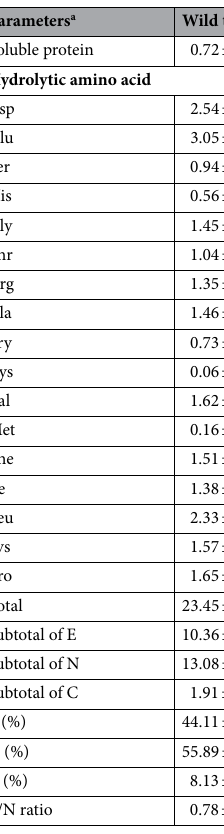
Table 2. Soluble protein and amino acids in sesame leaves (mg/g). a Asp aspartic acid, Glu glutamine, Ser serine, His histidine, Gly glycine, Thr threonine, Arg arginine, Ala alanine, Try tyrosine, Cys cysteine, Val valine, Met methionine, Phe phenylalanine, Ile isoleucine, Leu leucine, Lys lysine, Pro proline, E essential amino acids, N non-essential amino acids, C essential amino acids only for children. b Values are means ± standard deviation ( n = 3). Data in the same row followed by * and ** are significantly ( P < 0.05) and very significant ( P < 0.01) different, respectively.